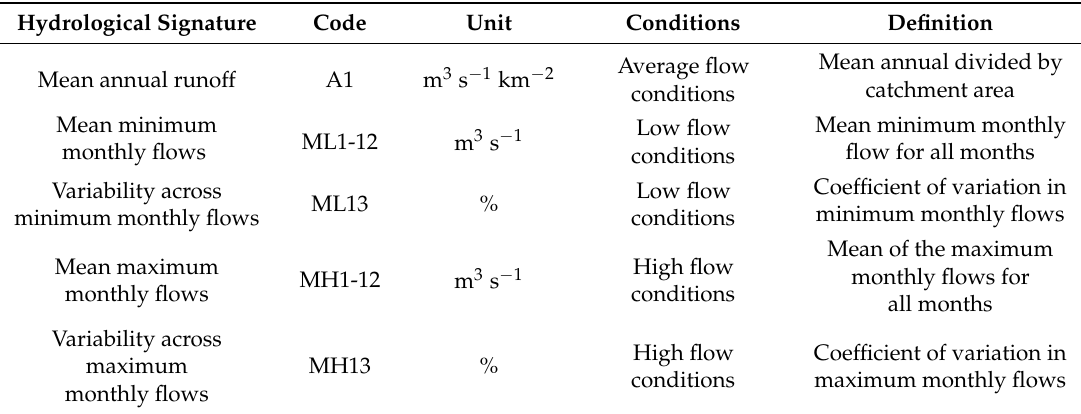
Table 1. Hydrological signatures utilized in the